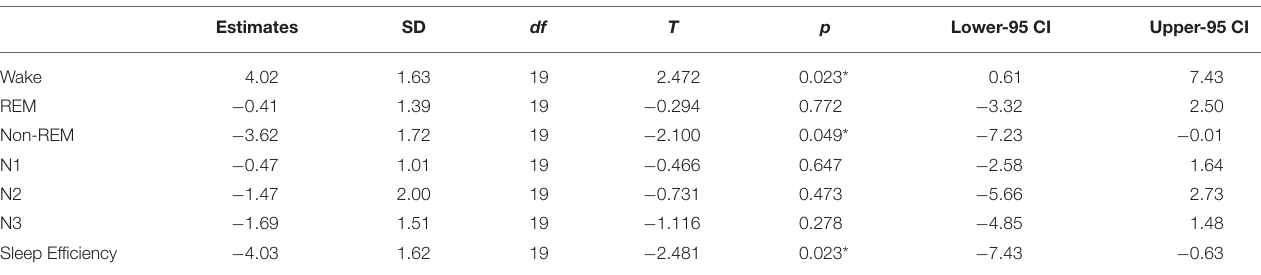
TABLE 4 | Overview of linear mixed models analysis for sleep indices (in percent) ∼ time. Estimates SD